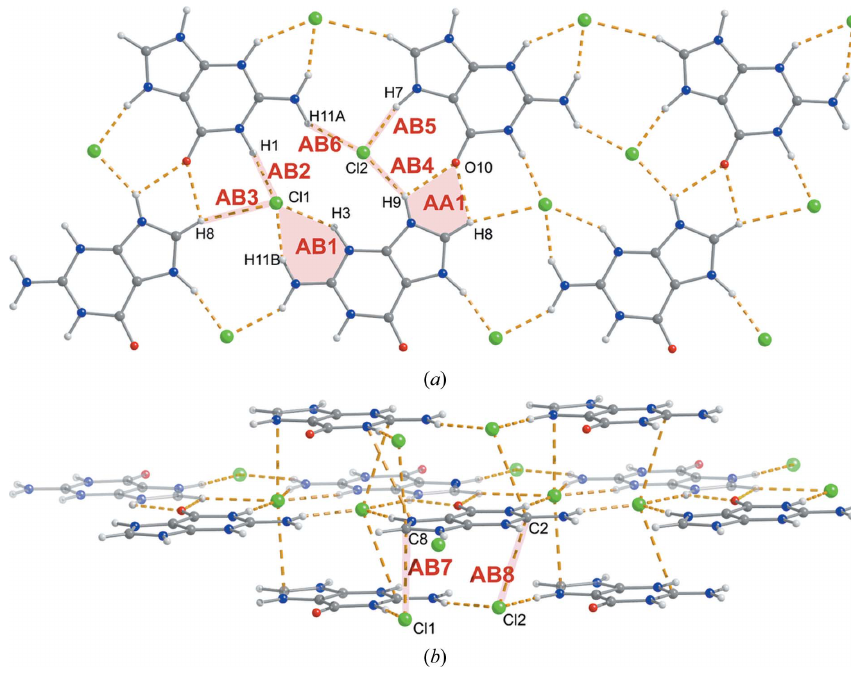
Figure 4 Dimeric motifs in the guaninium dichloride (GDC)